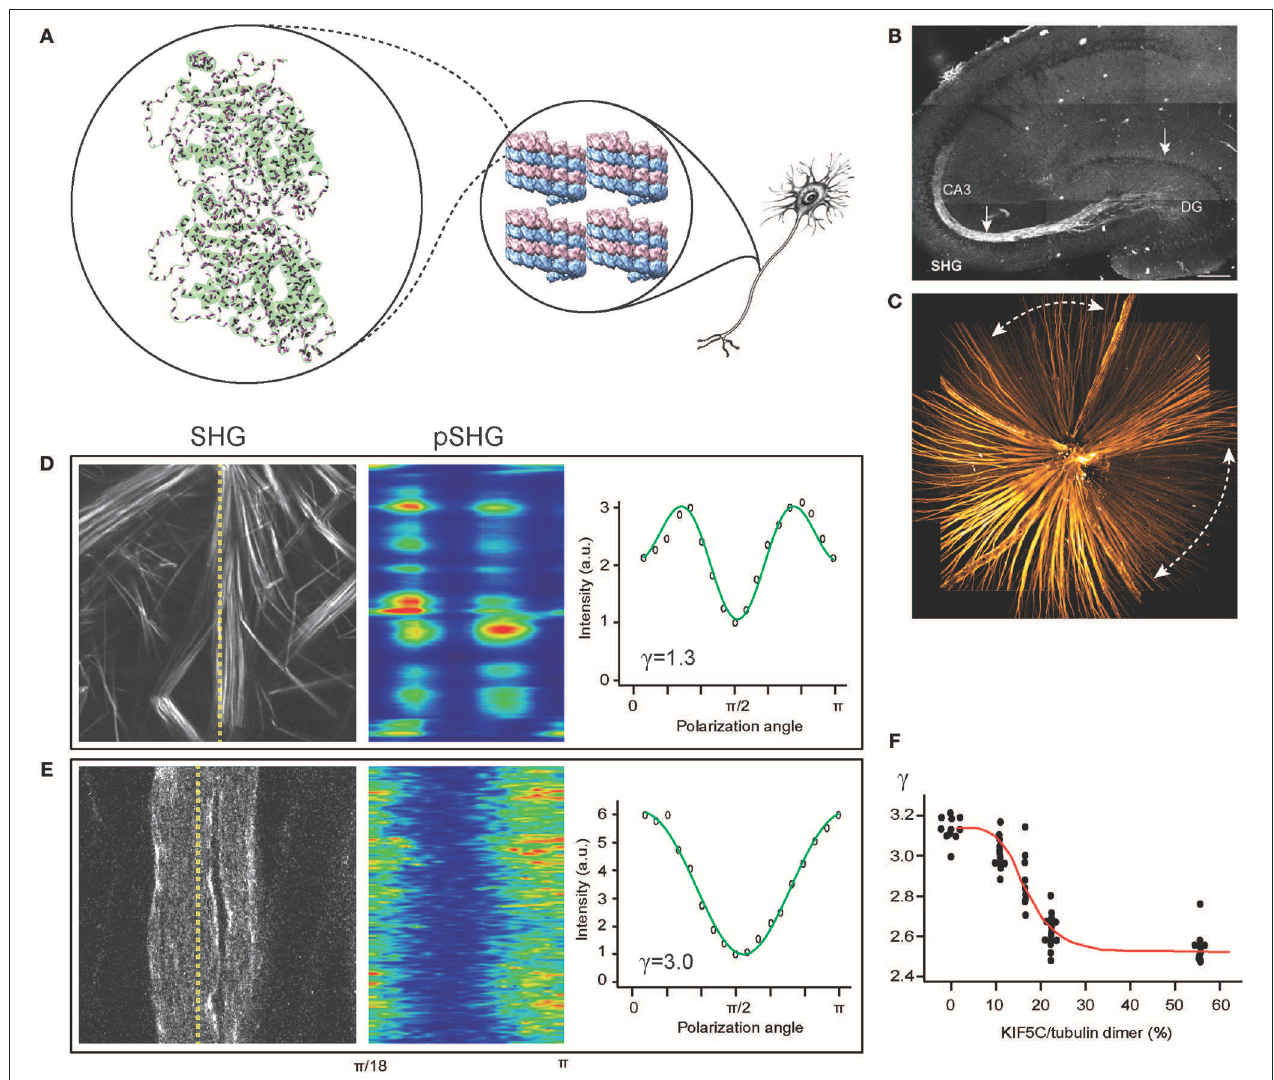
FIGURE 1 | SHG for imaging the central nervous system (CNS). (A) Tubulin heterodimer (PDB: 1TUB) with peptide bonds (magenta rods) in microtubule lattice (PDB: 5SYF), which are uniformly oriented in the axon. (B) The mossy fibers in an acute slice of the hippocampus imaged by SHG (reproduced from Dombeck et al., 2003). (C) The retinal nerve fiber bundles in the fresh wholemount retina of glaucoma-developing DBA mouse visualized by SHG. Dashed lines, characteristic sectorial degeneration of glaucoma (redrawn from Sharoukhov et al., 2018). (D,E) SHG intensity for collagen (D) and microtubules (E) , respectively, and SHG polarization anisotropy (pSHG) corresponding to the dashed lines as a function of the polarization angle (redrawn from Sharoukhov and Lim, 2016). (F) SHG anisotropy of microtubule changes upon KIF5C binding. Red line, the best fit to the modified Hill equation (redrawn from Shima et al.,